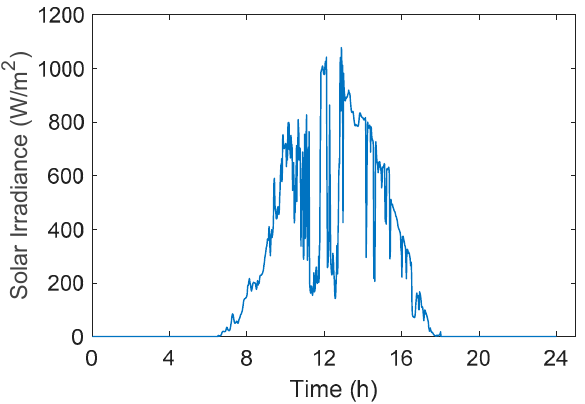
Figure 4. PV generation profile for one day at 1-min resolution [35].